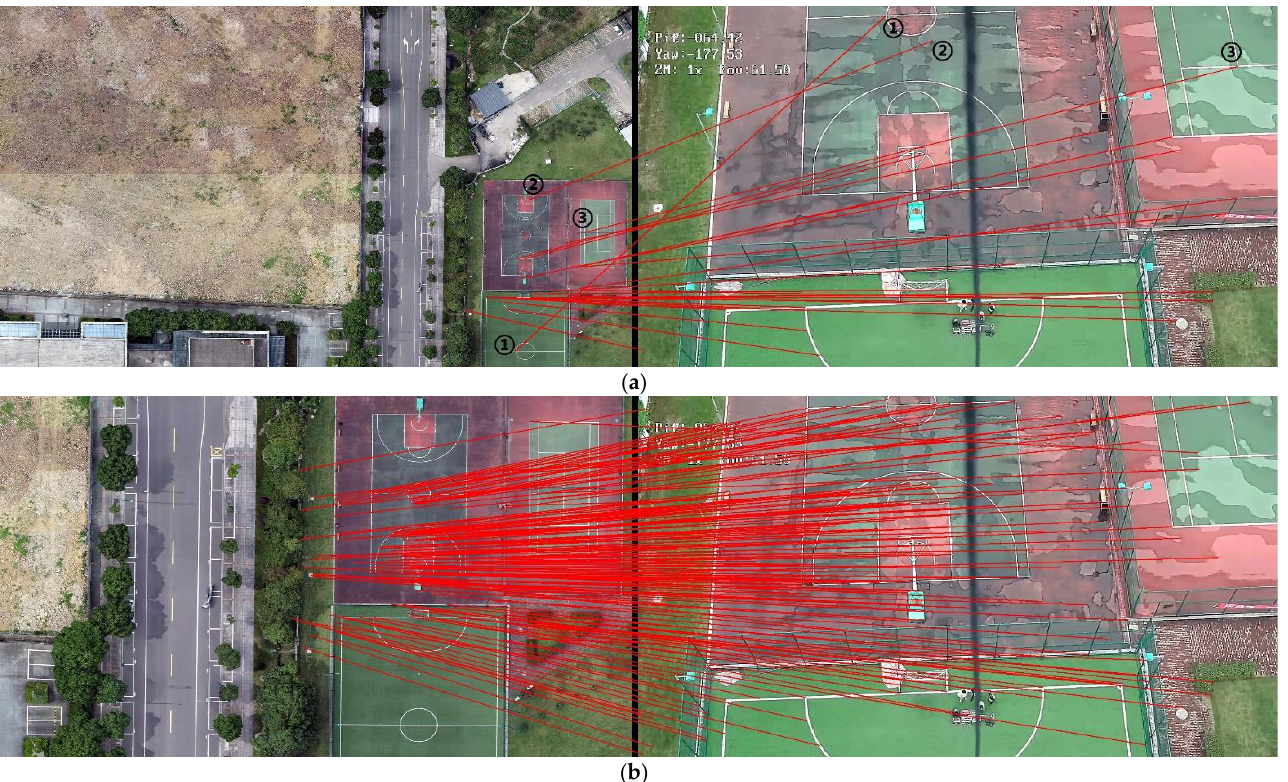
Figure 12. Comparison of the matching effects prior to and following blocking: ( a ) effect of matching prior to blocking (the map is on the left, the camera image is on the right, and the numbers in the figure represent incorrect matches); ( b ) effect of matching following blocking (the map is on the left and the camera image is on the right). Table 2. Real-time performance of the algorithms.